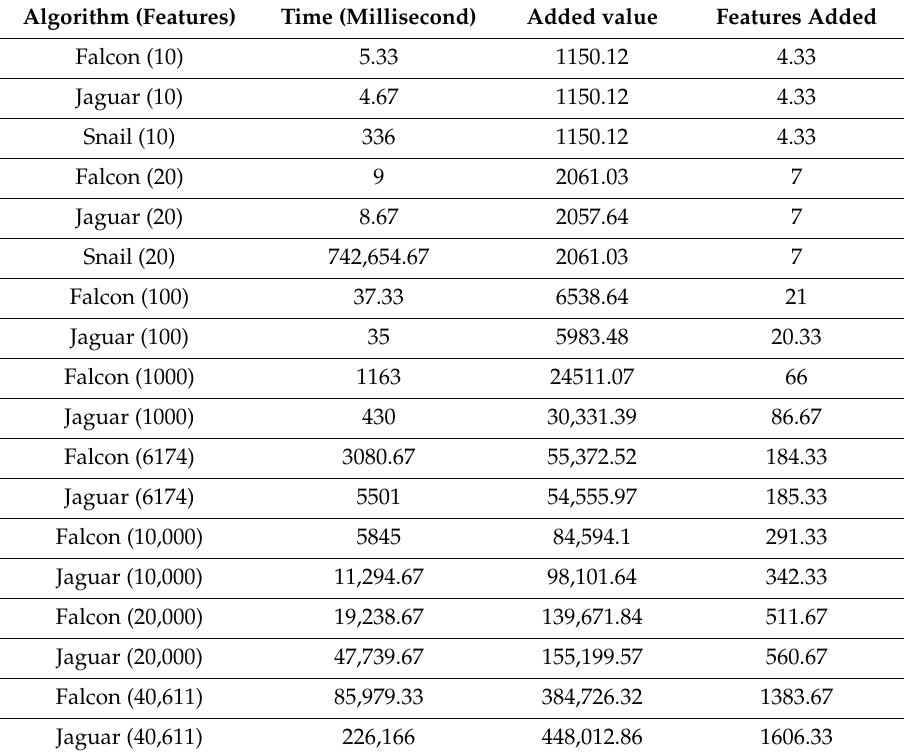
Table 7. Average comparison between feature selection